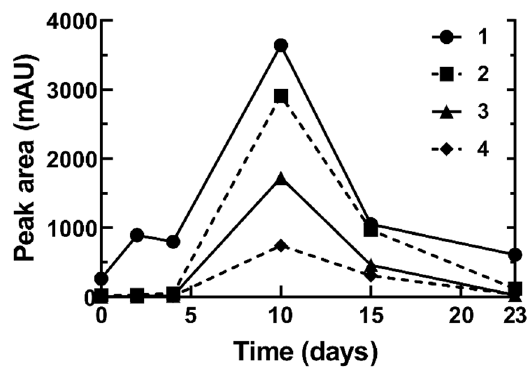
Figure 4. Formation of HODEs and KODEs upon autoxidation of linoleic acid at room temperature. Separation of the mixture 1 (HODEs) peak could not be fully achieved, and it was analyzed as a mixture. The peaks identified were as follows: 1 : mixtures of 8-HODE, 9-HODE, 10-HODE, and 12-HODE; 2 / 3 : 13-KODE; 4 : 9-KODE. All HODEs and KODEs were quantified by comparing the peak areas of products relative to day 0. HPLC was used to monitor the autoxidation reactions and the results were shown as means ± S.D., averaged from three replicates ( n = 3).